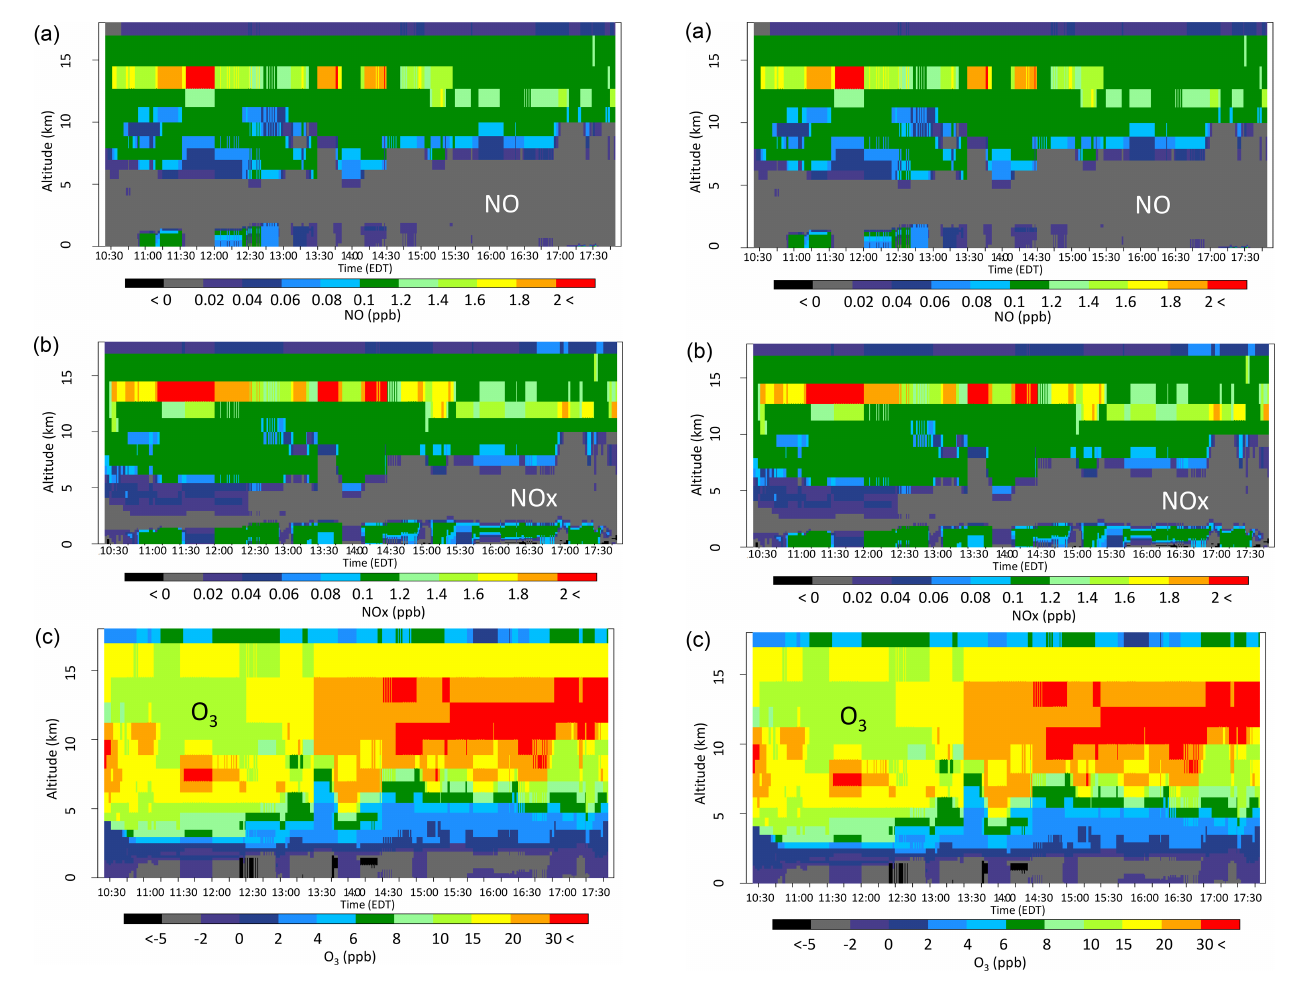
Figure 9. The vertical-time difference between mNLDN and Base during the P-3B flight period on 28 July 2011 for (a) NO, (b) NO x , and (c) O 3